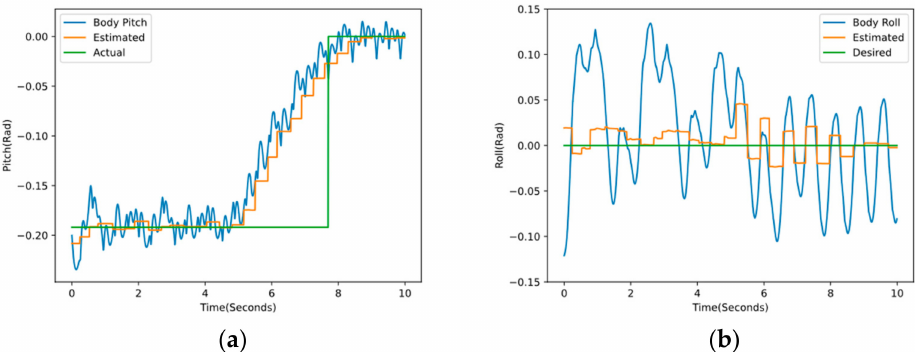
Figure 16. Changes in the attitude angle of the robot on the 11 ◦ slope. ( a ) Changes in the pitch angle of the robot on the 11 ◦ slope. ( b ) Changes in the roll angle of the robot on the 11 ◦